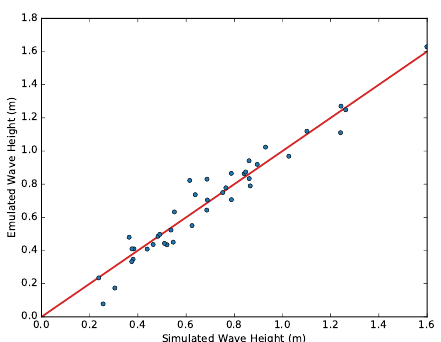
Figure 3. Wave heights calculated from the truth model (SPH) compared to emulated wave heights from the GPE, for the same 40 sets of input parameters. Red line shows the 1:1